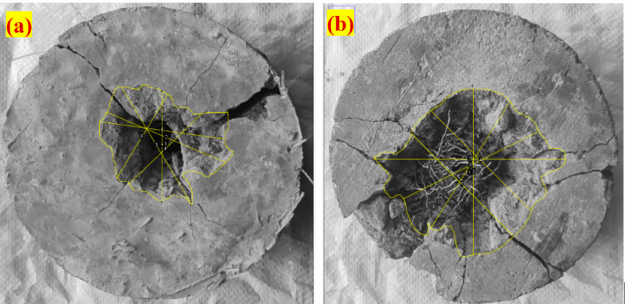
Figure 17. Image processing for measured damage area ( a ) Top and ( b ) Bottom.